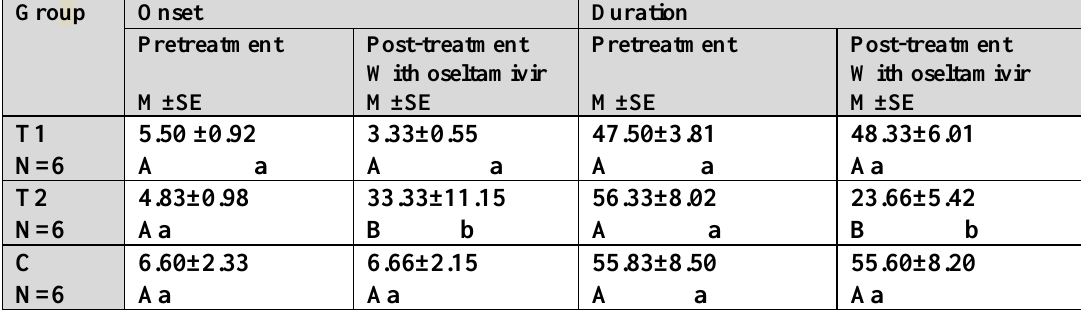
Table (1):-Barbiturate (Thiopental sodium) sleeping time /minute in rats dosed therapeutic dose 1mg/kg.BW of Oseltamivir for different experimental periods.